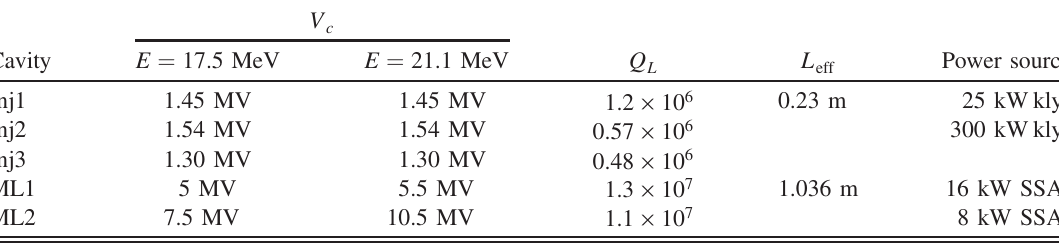
TABLE I. rf and cavity parameters during the cERL beam commissioning in pulse